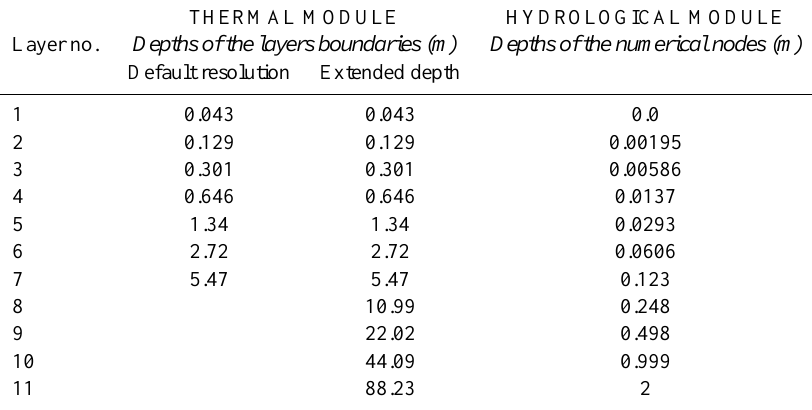
Table 3. Vertical discretizations of the thermal and hydrological modules in the default configuration, and in the extended-depth configuration (thermal module